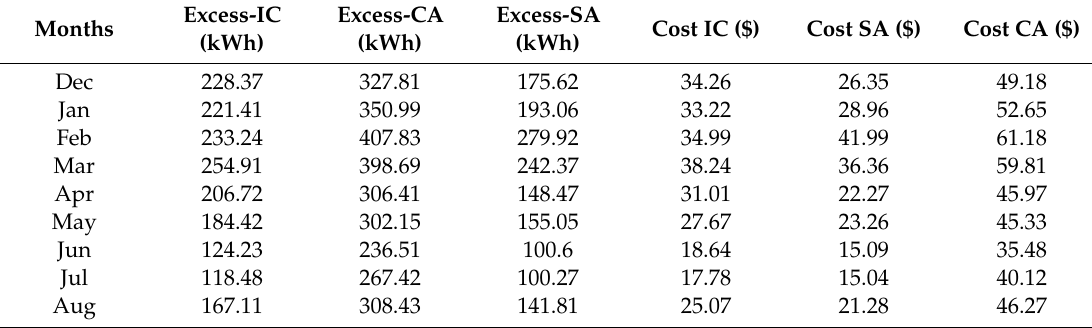
Table A6. Total monthly excess energy and costs obtained from three strategies at